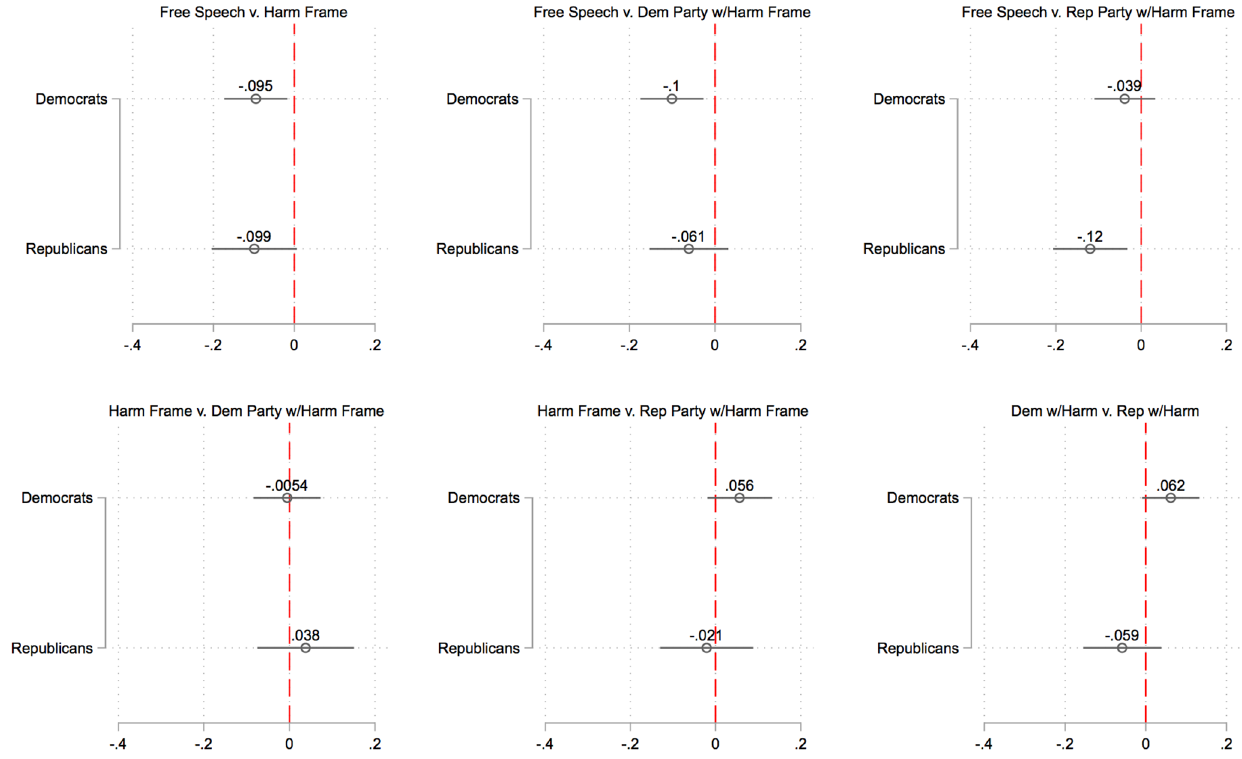
Figure 5. Experimental treatment effects on anti-Muslim tolerance by party ID (Study 1). Note. Open dots represent the estimated marginal effects of the experimental treatment (the comparison described in each panel's title) for Democrats and Republicans, with lines representing 95% confidence intervals. The three panels in the top row present marginal effects generated from the OLS regression model without demographic controls provided in Table 3, Column 4. The left and middle panels in the bottom row present marginal effects generated from the OLS regression model without demographic controls provided in Table 3, Column 5. The right panel in the bottom row presents marginal effects generated from the OLS regression model without demographic controls provided in Table 3, Column